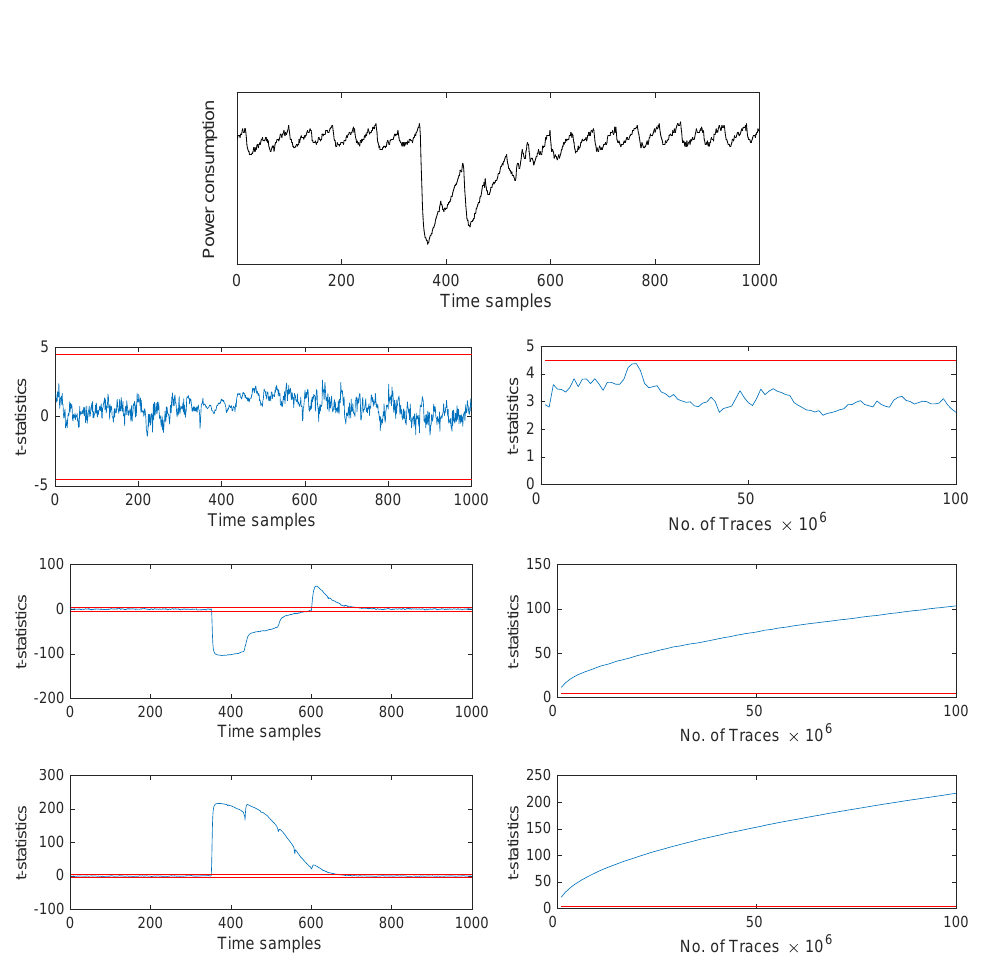
Figure 21: Sample power trace and univariate non-specific t -test results with 100 million measurements for two composed DOM- indep multiplications ( d = 2) based on GF (2 4 ) multipliers with only the mandatory registers applied. The second to fourth row show the t -statistics for the statistical moments 1 to 3, respectively, arranged like